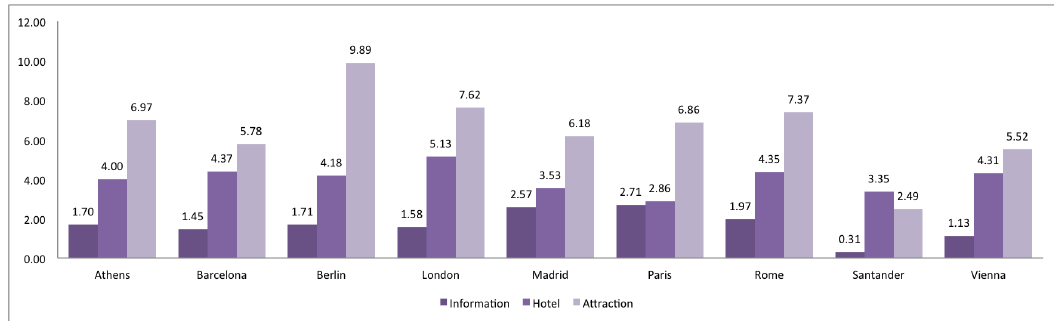
Figure 25. Consistency study of shop in Europe. Standard deviation of tag number.